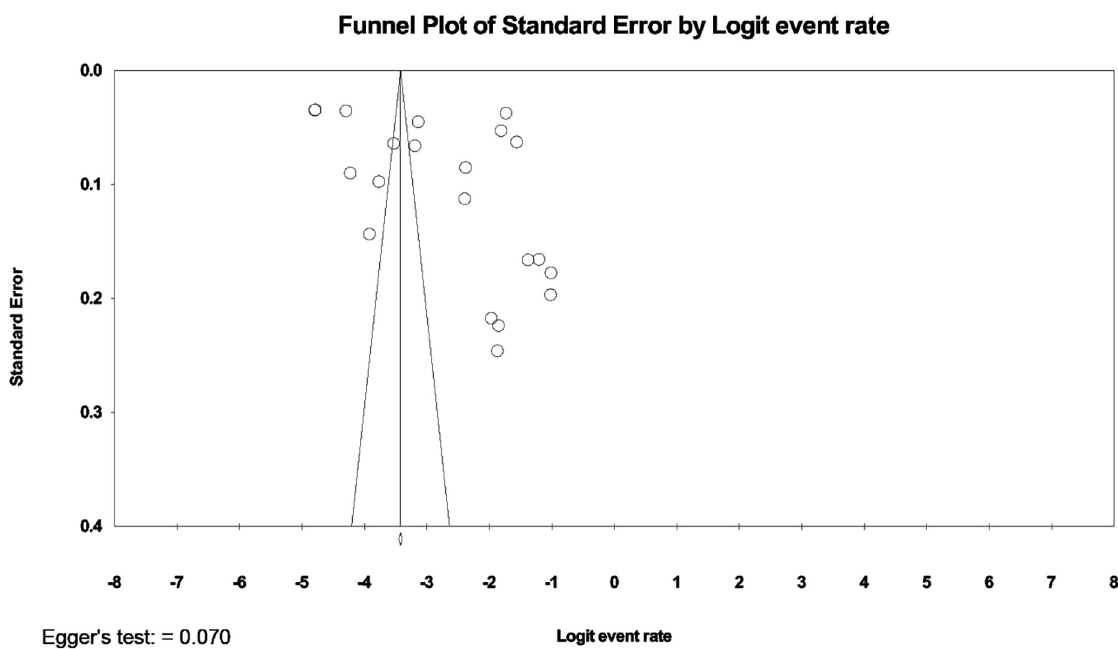
Fig 4. Funnel plot for publication bias test across